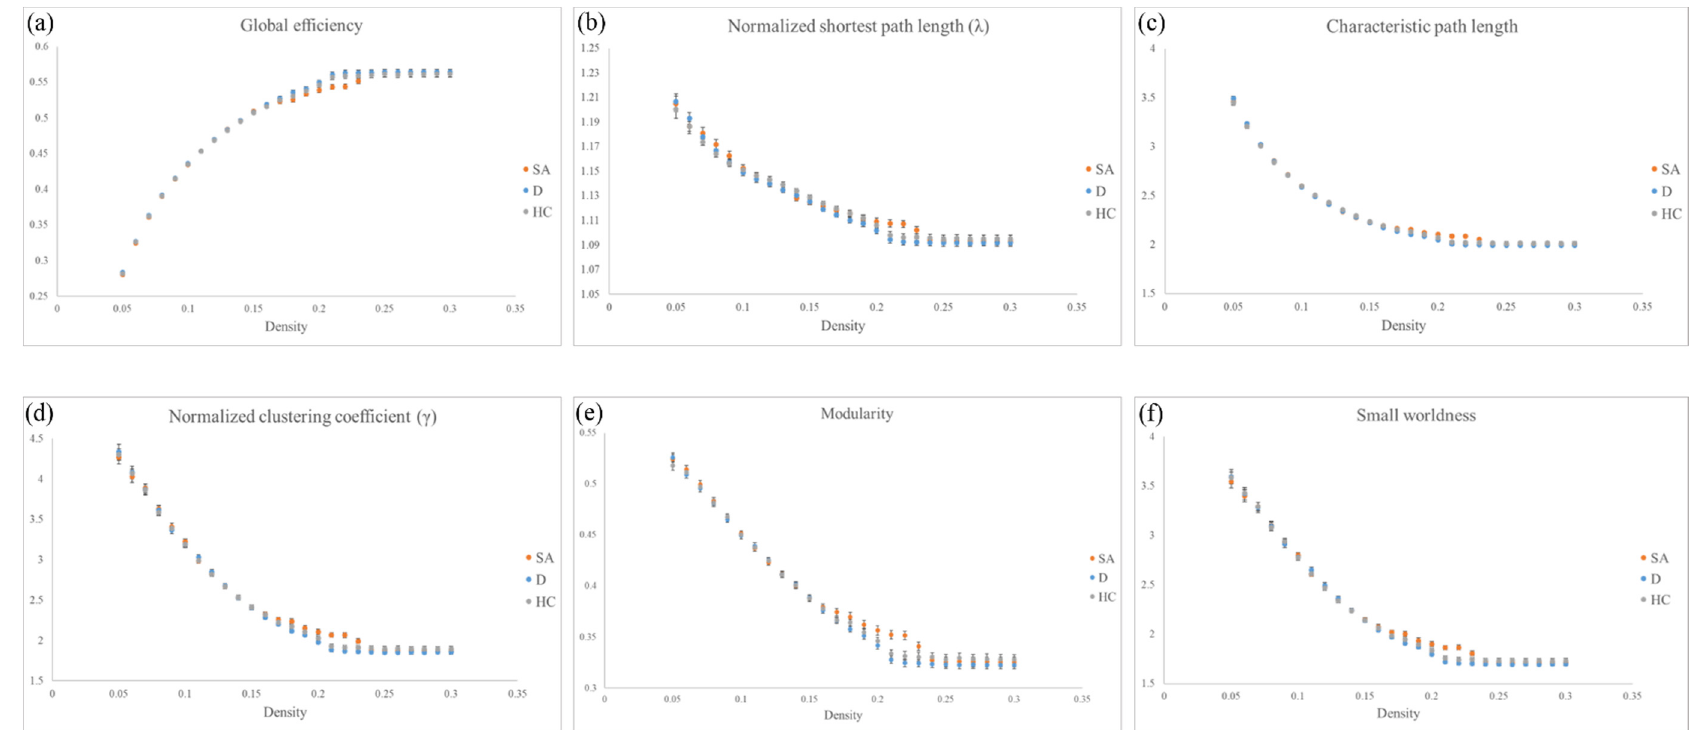
Figure 3. Topological parameters of graph theoretical analysis. Topological parameters including ( a ) global efficiency, ( b ) normalized shortest path length ( λ ), ( c ) characteristic path length, ( d ) normalized clustering coefficient ( γ ), ( e ) modularity and ( f ) small-worldness index among the three groups (SA, D and HC).